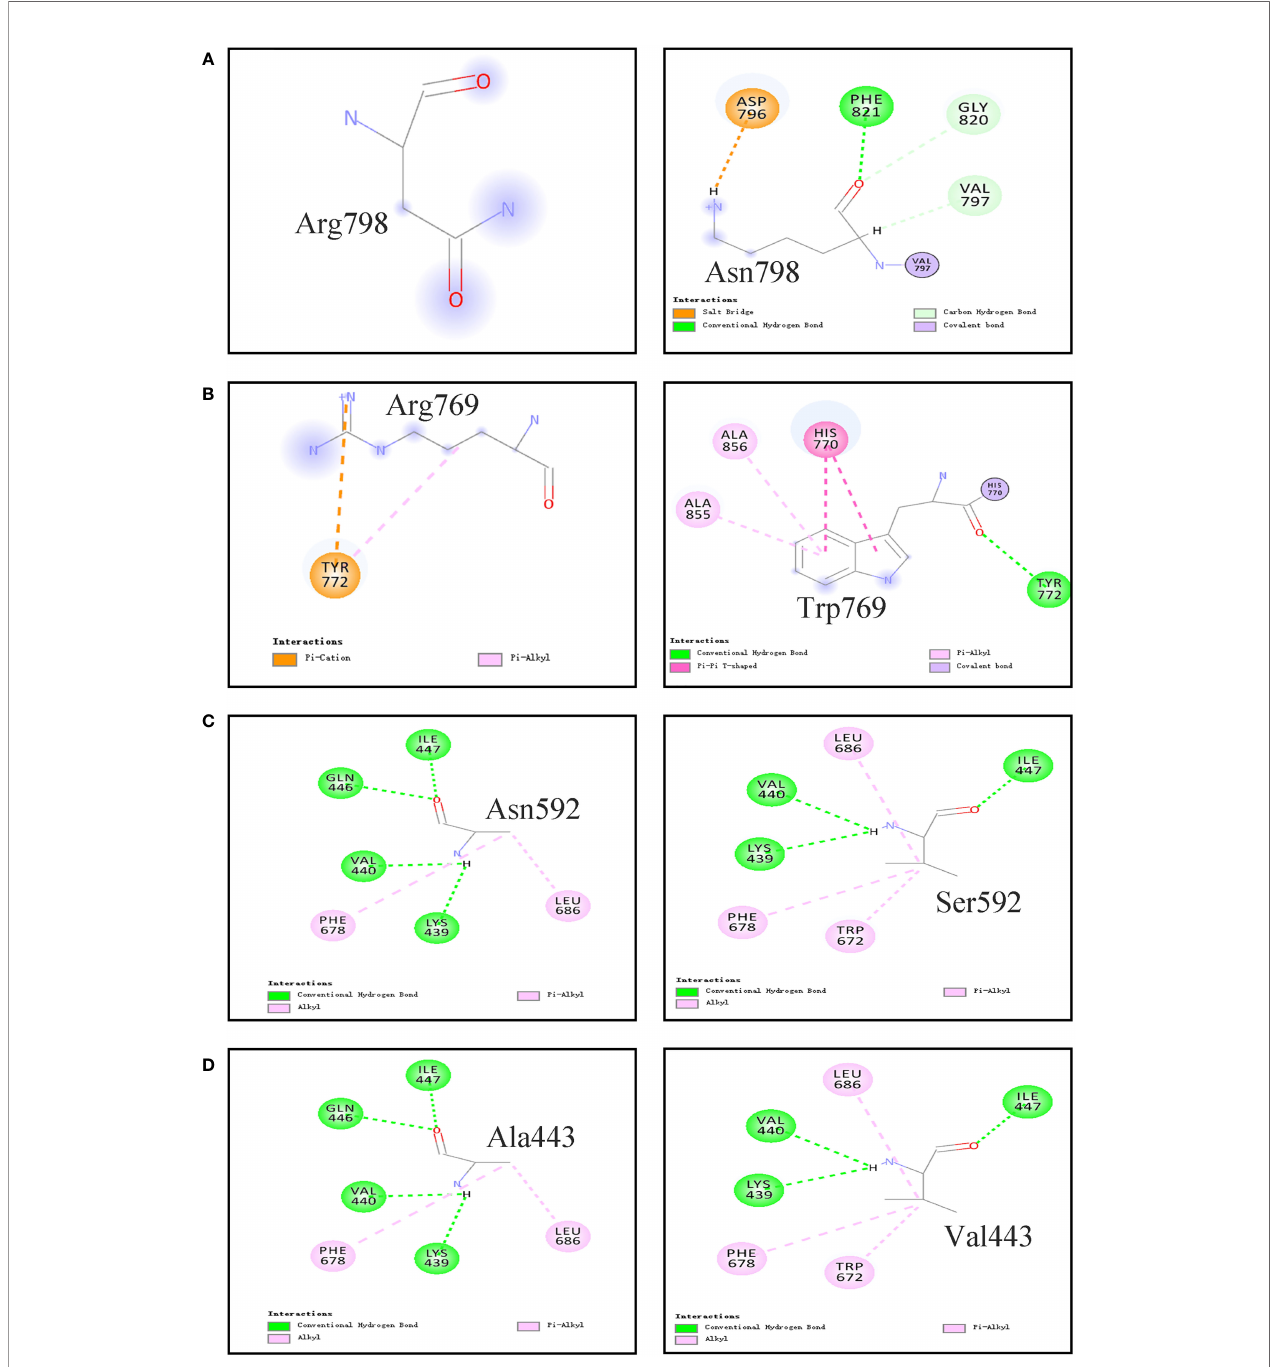
FIGURE 3 | Non-covalent Interactions between the studied residues with surrounding residues in the TPO protein which are generated by computer. (A) p.Asn798Arg; (B) p.Arg769Trp; (C) p.Asn592Ser; (D)